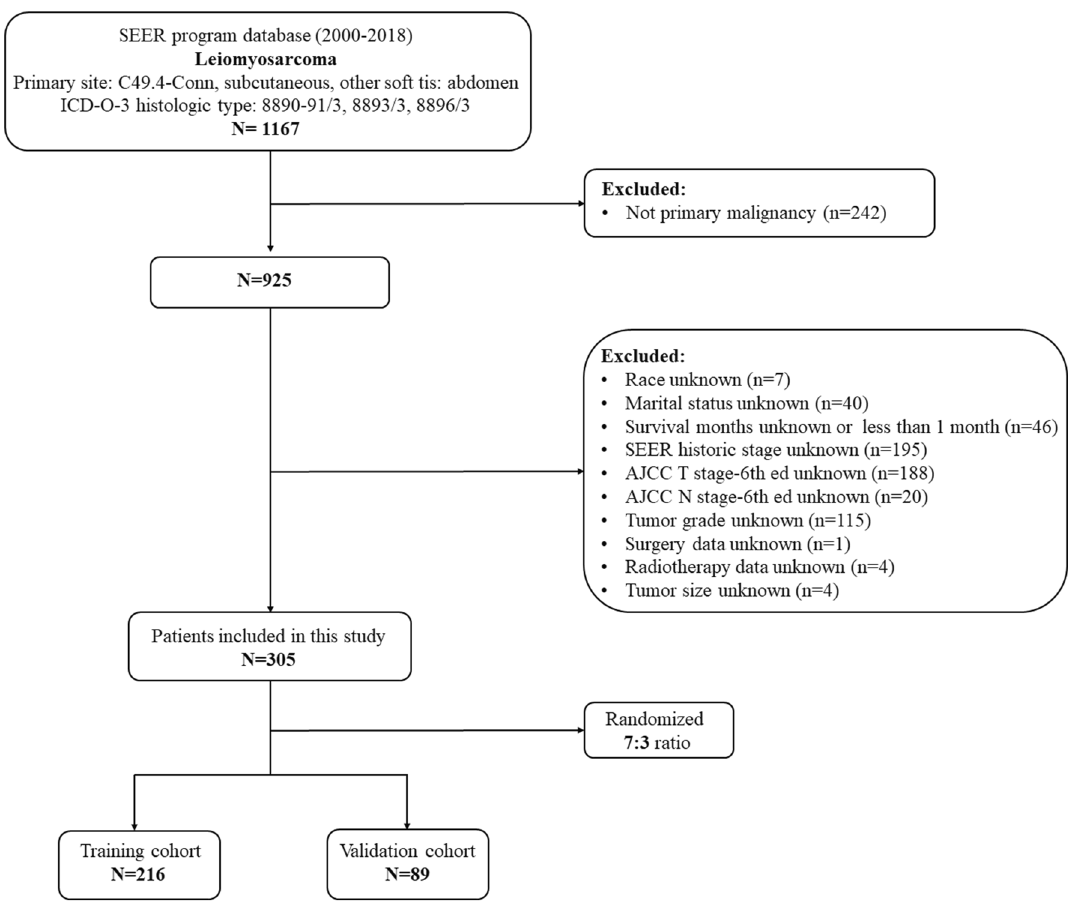
Figure 1. The flowchart of patient